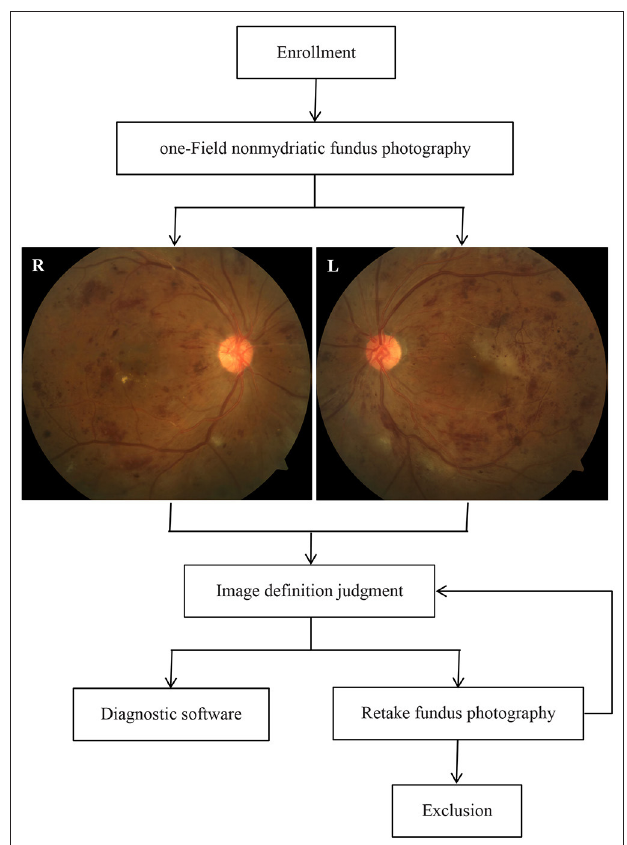
FIGURE 1 | Study procedures in the study of the CARE system.